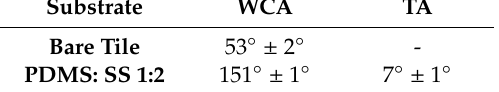
Table 2. Water contact angles (WCA) and tilting angles (TA) of glass substrates coated with super-hydrophobic solution.